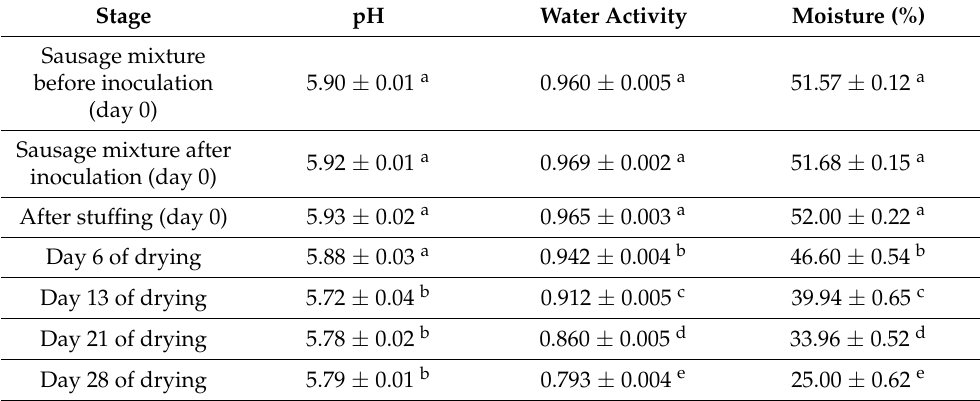
Table 1. Physicochemical parameters of inoculated Riojano chorizo during processing. Stage Water Activity